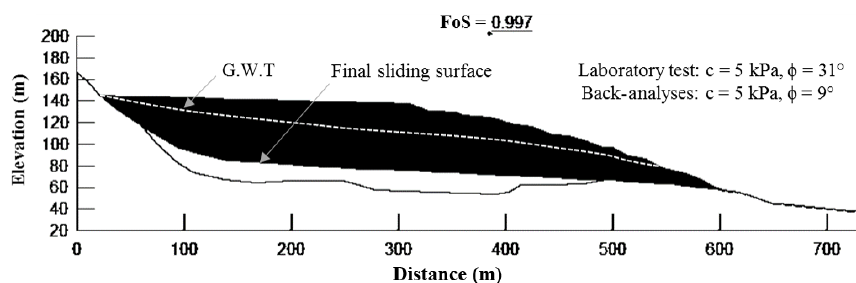
Figure 18. Back-calculated mobilized strength by using 2-D numerical model with